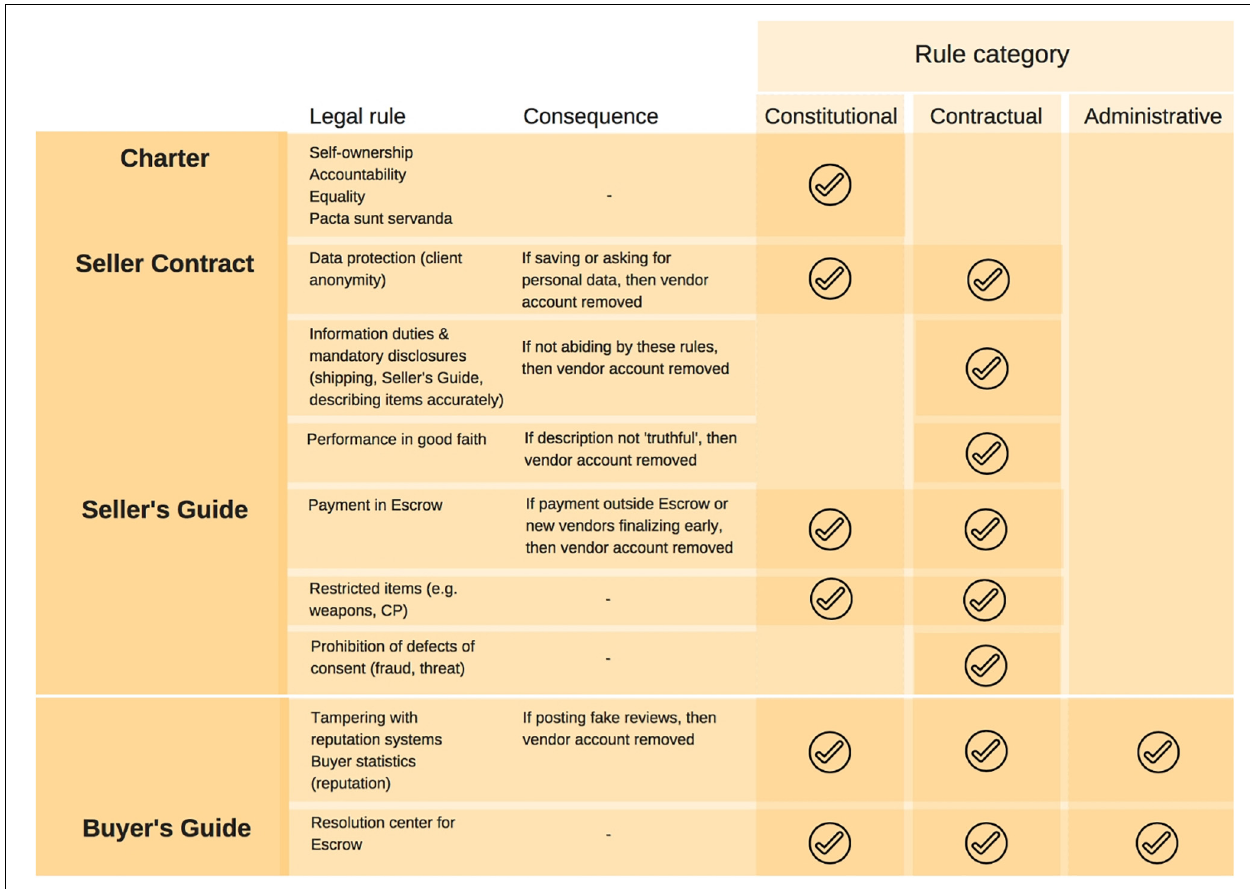
Frontiers in Blockchain |